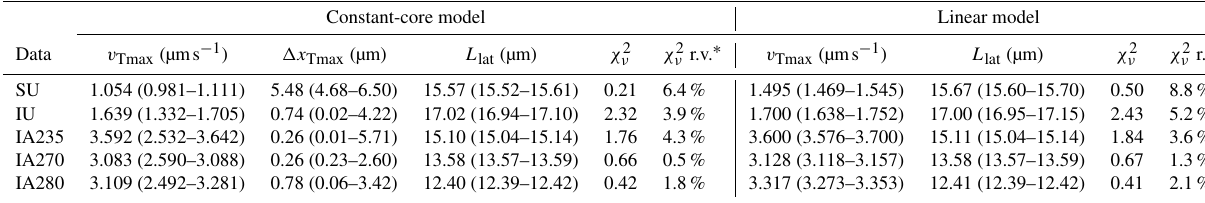
Table 2. Best-fit model parameters, ranges of comparable fits, and goodness of fit. Constant-core model